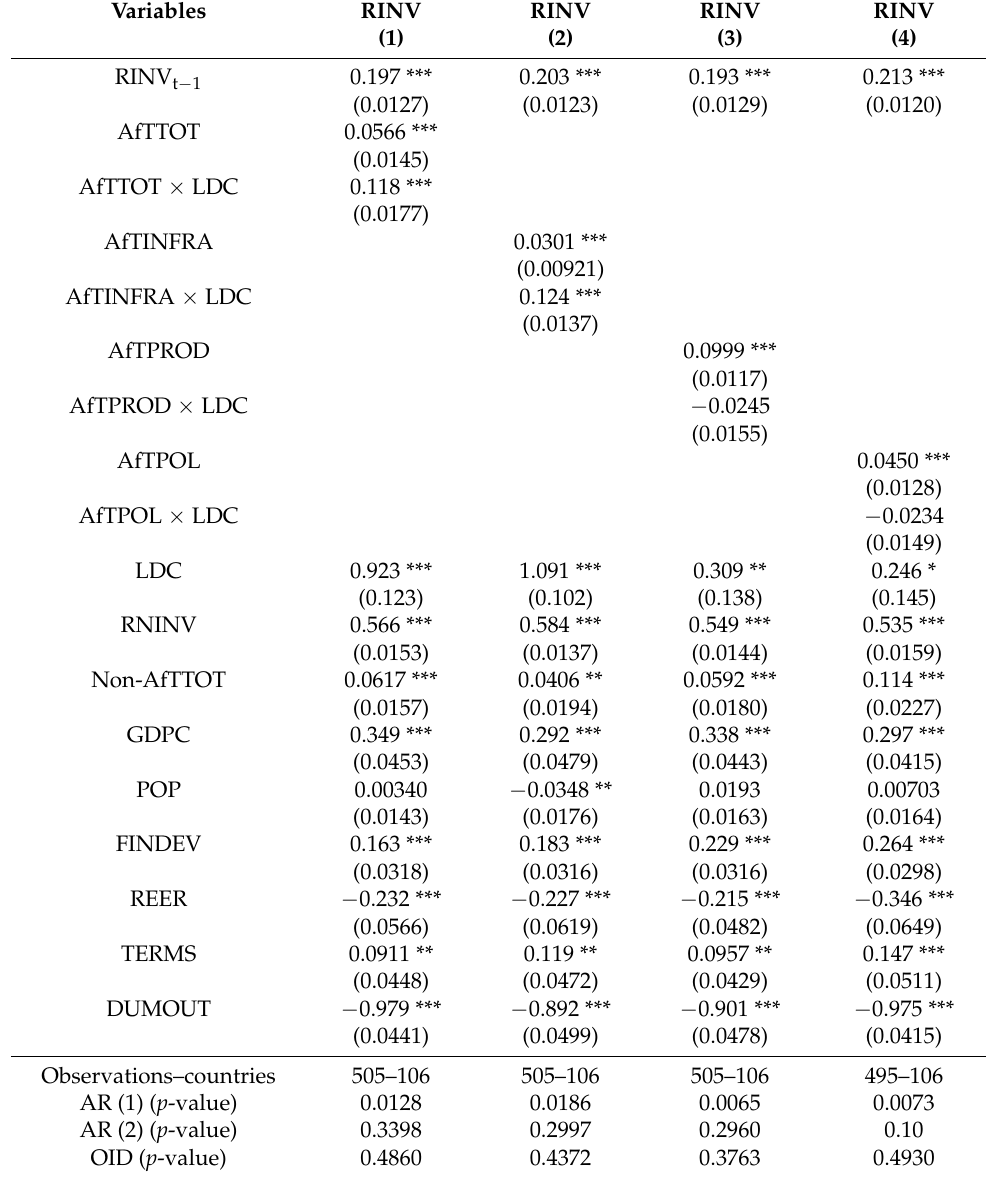
Table 3. Effect of AfT flows on investment-oriented remittance flows across countries in the full sample, as well as in LDCs versus non-LDCs. Estimator: Two-step system GMM.